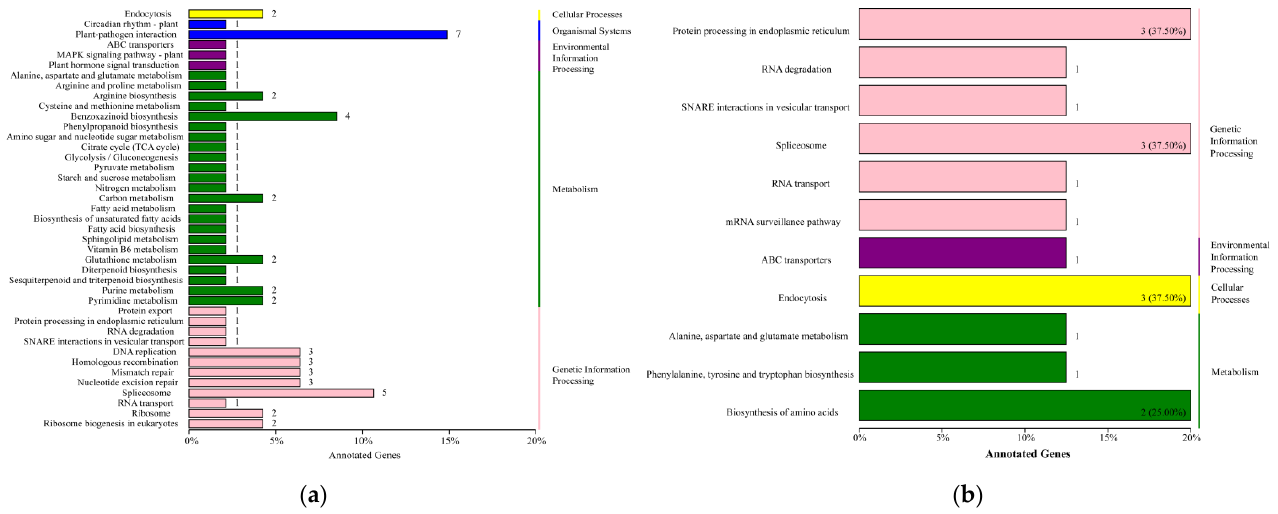
Figure 8. KEGG pathway enrichment analysis of the DEGs. ( a ) Classification of DEGs with KEGG pathway annotations of BS vs. MS. ( b ) Classification of DEGs with KEGG pathway annotations of BR vs. MR. (Y-axis: name of KEGG pathway annotation; X-axis: number and percentage of genes involved in this pathway over counts of all annotated genes).